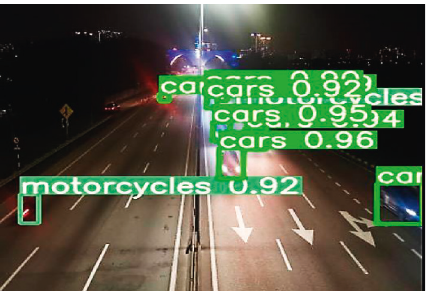
Figure 18: Another example of model not detecting the car in the nonlighted